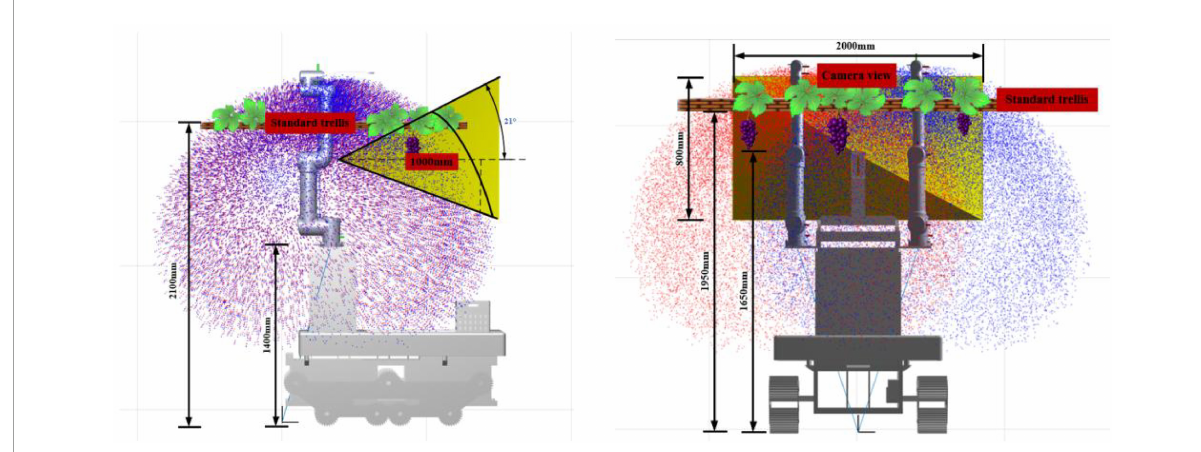
FIGURE7 Operating space point cloud of the dual-arm harvesting robot.